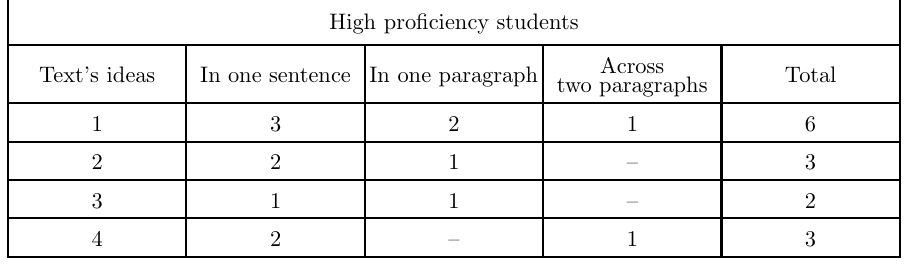
Used ideas (average proficiency students) Average proficiency students Across Text’s ideas In one sentence In one paragraph Total two